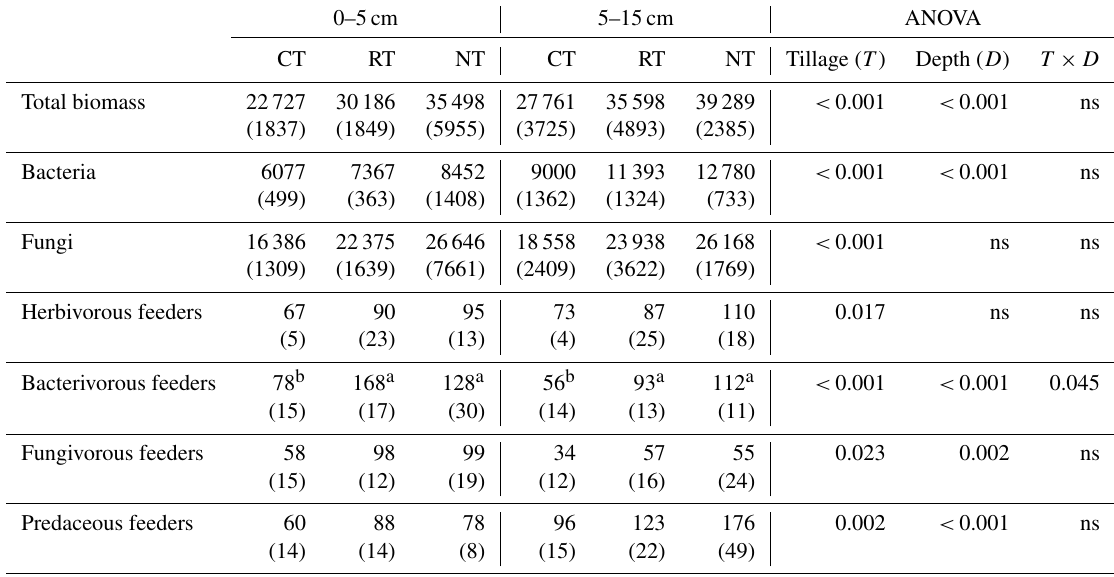
Table 2. Cumulative soil biotic biomass (expressed as mgCm − 2 ) over the soybean growing season under different tillage practices (standard deviation – SD).